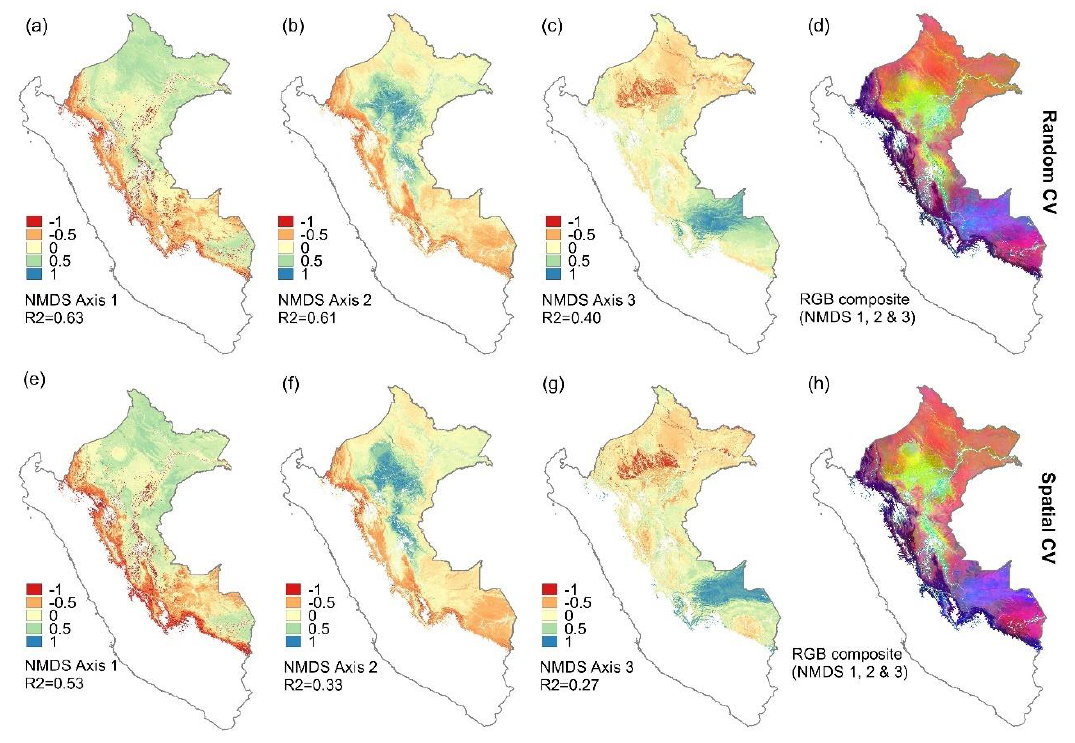
Figure 3. Spatial patterns in the community composition of tree genera across Peruvian Amazonia as represented by the predicted NMDS ordination scores. Predicted values were obtained with random forest regressions using a selection of Landsat and environmental variables (Table 1). The variable selection was based on forward feature selection and cross-validation was done using either 10 folds of randomly selected calibration data ( a – d ) or 5 spatially constrained folds ( e – h ). Panels a–c and e–g show predicted values for a single ban, and panels d and h the predicted values for all three NMDS axes assigned to red, green, and blue, respectively. Non-forest areas and areas above the 2000-m elevation were masked out and are shown in white.